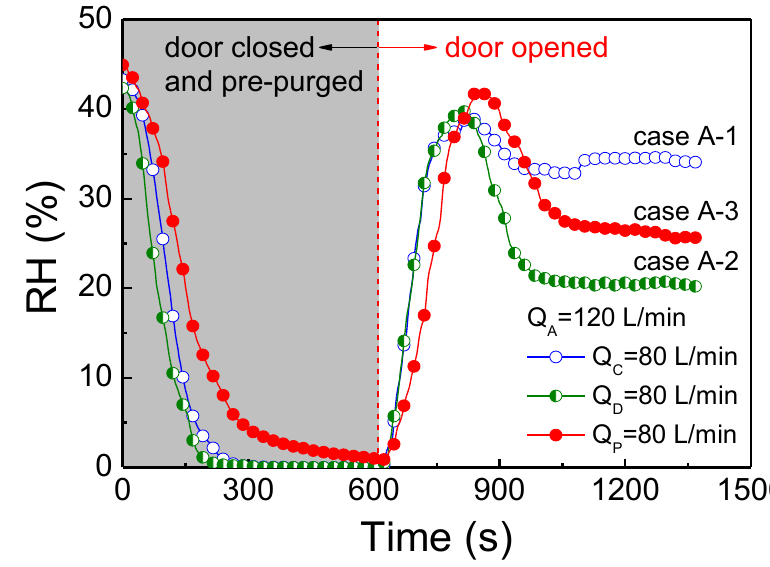
Figure 7. RH evolutions for different purge processes with CDA flow rates of 120 L/min to air curtain and 80 L/min to FOUP-purge system.